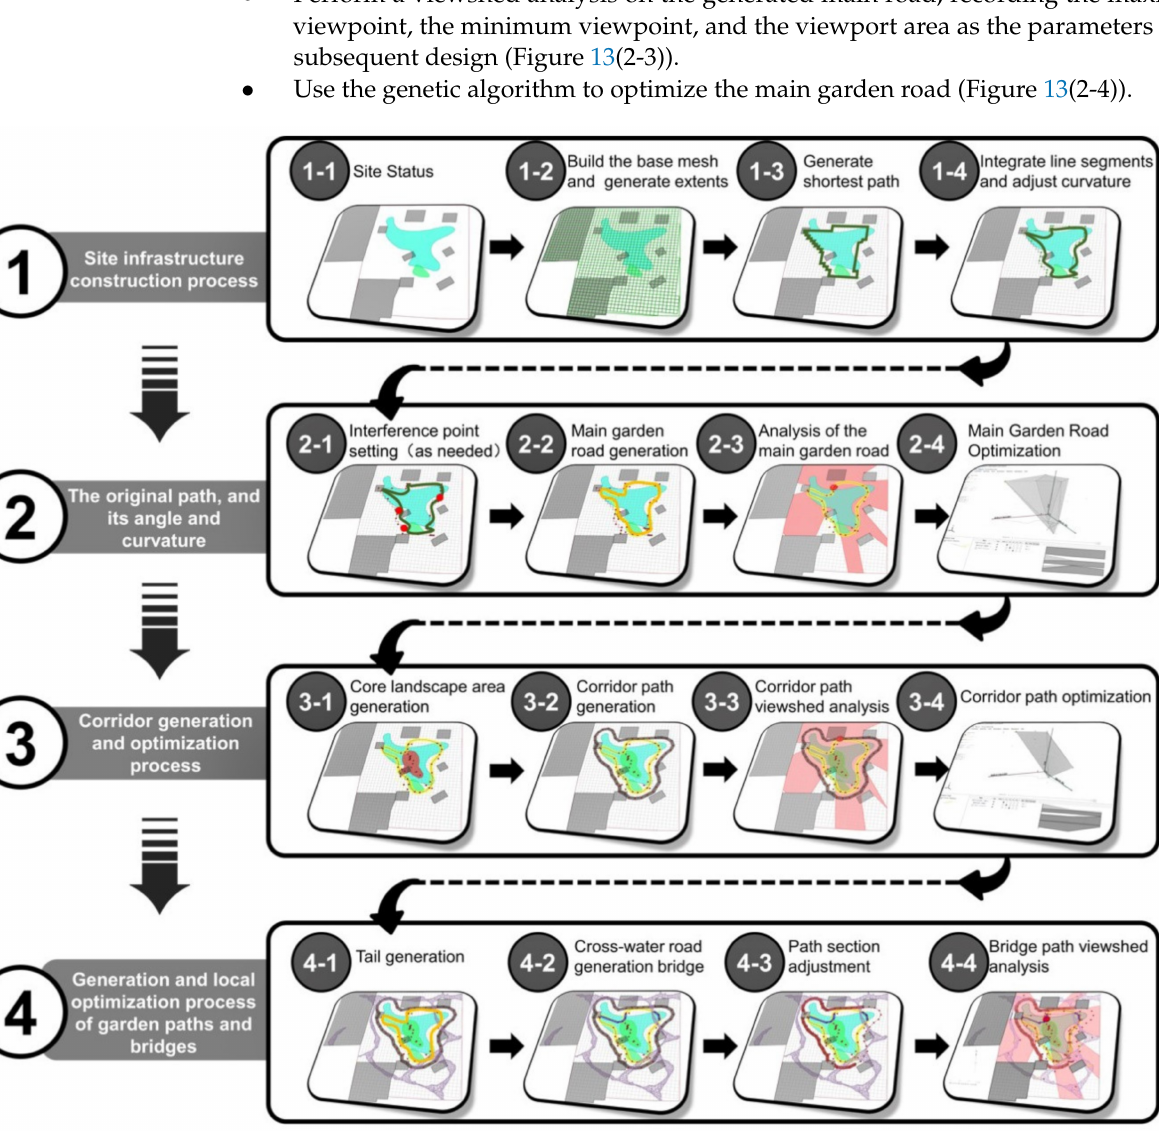
Figure 13. Parametric design steps and